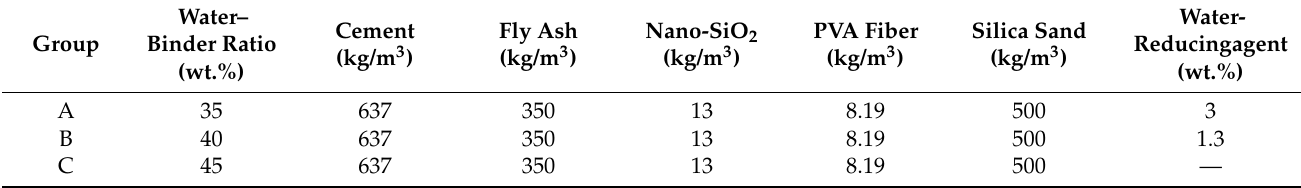
Table 4. Mixing proportions of the